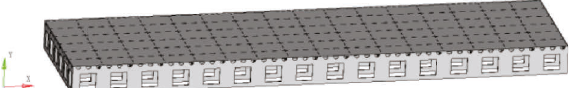
Figure 1: Structure of the tool for manufacturing composite